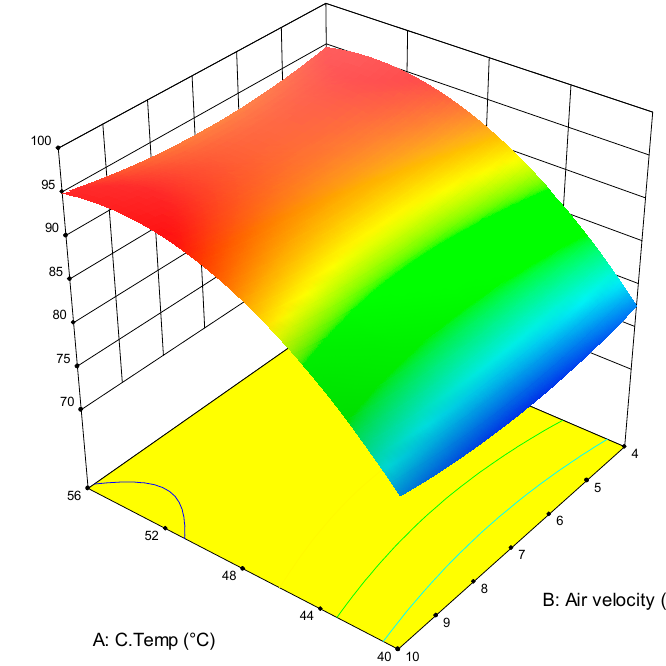
Figure 4. Response surface plot showing the effect of temperature and airflow on dewatering efficiency.